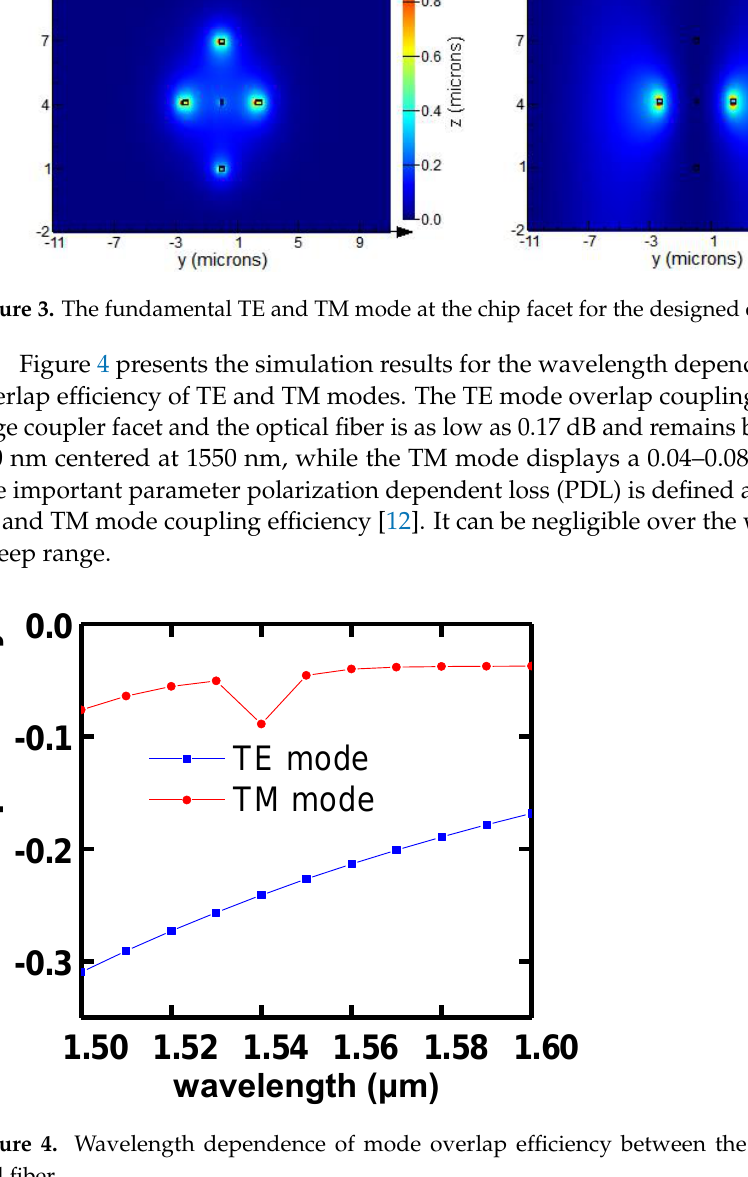
Figure 5. Simulated modal field evolution along the coupler: ( a ) near the edge coupler facet; ( b ) upper (or lower) Si 3 N 4 waveguide termination point; ( c ) curved waveguide termination point; ( d )